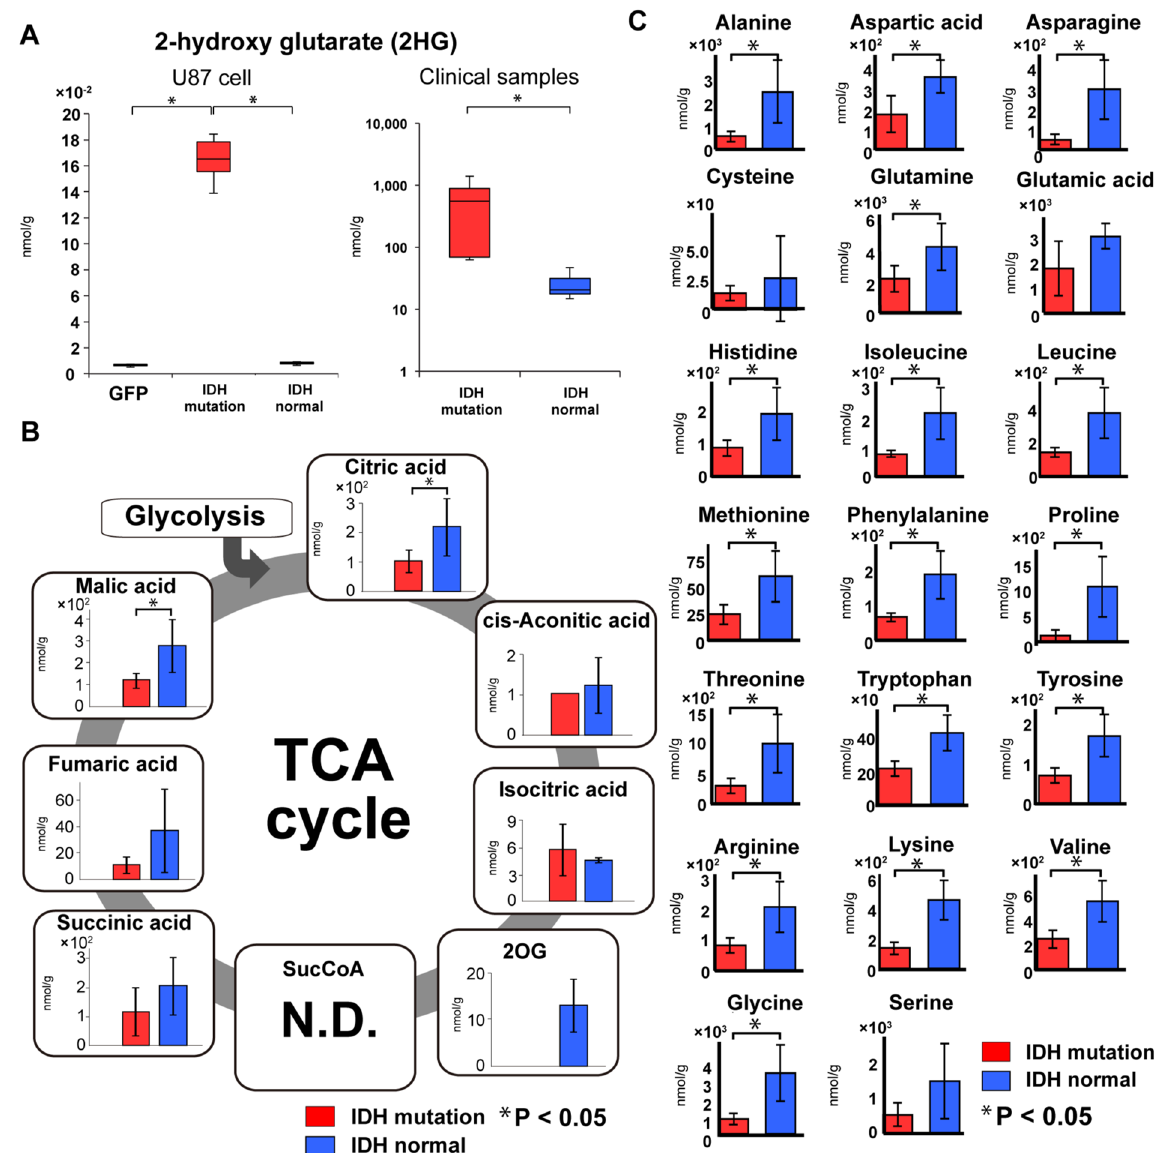
Figure 2. D-2-hydroxyglutarate, TCA cycle, and Amino acid in IDH mutant gliomas. ( A ) A box-whisker, the levels of D-2-hydroxyglutarate (D-2HG) were specifically elevated in IDH mutant glioma cells and clinical tumor specimens (red bars). For the U87 glioblastoma cell experiment, the vertical scale shows relative quantification based on the internal standard. ( B ) 2OG was considerably reduced in the IDH mutant glioma group (red bars) in clinical tumor specimens, and downstream intermediates of 2OG in the TCA cycle were also reduced. Each vertical scale shows the absolute quantification (nmol/g). ( C ) Amino acid production was reduced in the IDH mutant glioma group (red bars). The vertical scale for each amino acid shows the absolute quantification (nmol/g). Green bar, empty vector-transfected cells; red bars, IDH1 R132H -transfected cells or IDH1 R132H mutant glioma tissues; blue bars, normal IDH1 -transfected cells or normal IDH1 glioma tissues; N.D., not detected; error bar, standard error of mean. * P <